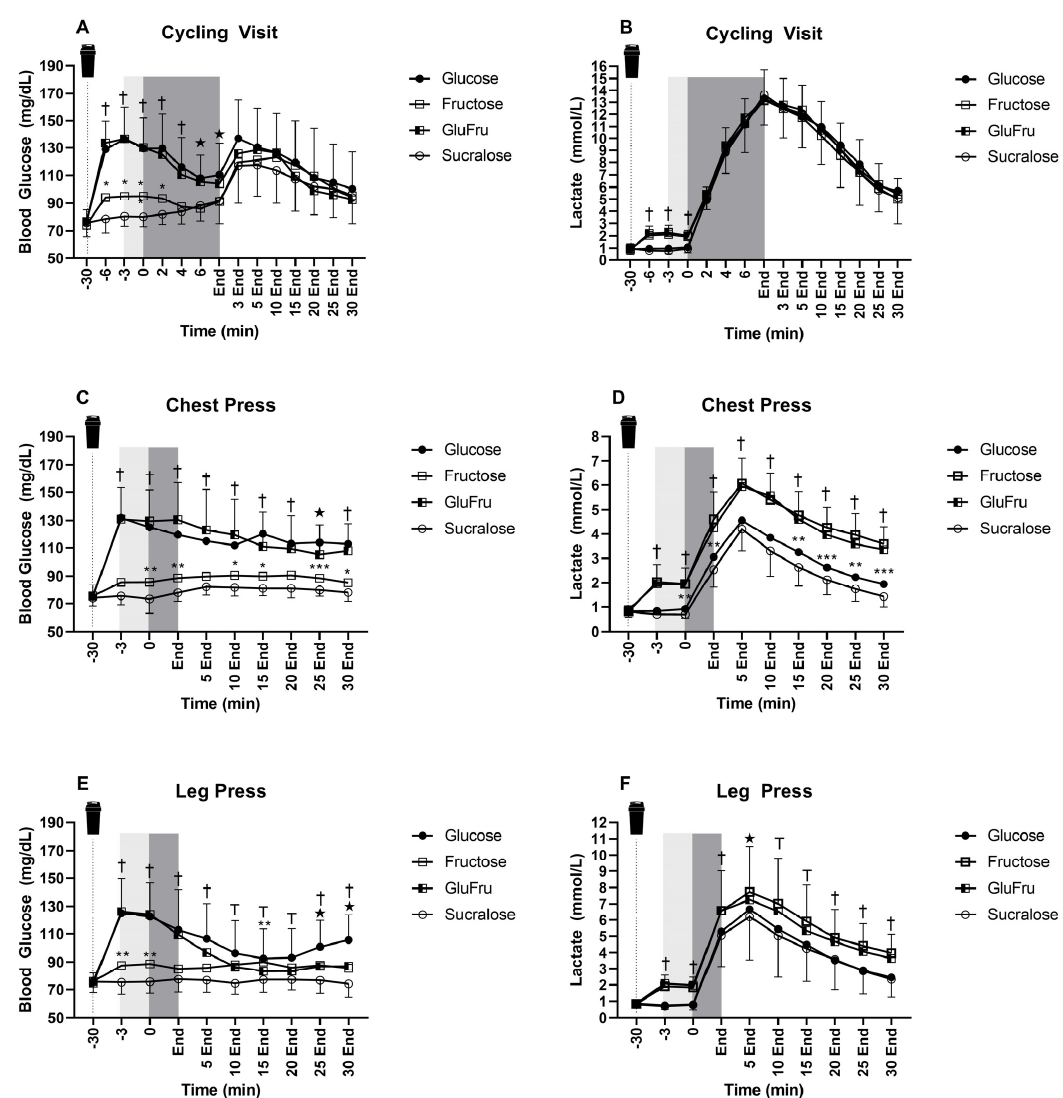
Figure 2. ( A ) Blood lactate during cycling study visits. Black circles indicate Glu. Open Squares indicate fru. Half open squares indicate GluFru. Open circles indicate sucralose. Light grey areas in- dicate warm up periods. Dark grey areas indicate exercise testing. † indicates statistical signi fi cance of Glu and GluFru compared to fructose and sucralose ( p < 0.001). * indicates statistical significance between fructose and sucralose ( p < 0.05), Stars indicate statistical significance of glucose compared to fructose and sucralose ( p < 0.01)., ( B ) Blood lactate during cycling study visits. † indicates statis- tical significance of Fru and GluFru compared to glucose and sucralose ( p < 0.001). ( C ) Blood glucose during chest-press visits. † indicates statistical signi fi cance of Glucose and GluFru compared to Fructose and sucralose ( p < 0.001). * indicates statistical significance between fructose and sucralose ( p < 0.05), ** indicates statistical significance between fructose and sucralose ( p < 0.01), *** indicates statistical significance between fructose and sucralose ( p < 0.001). Stars indicate statistical signifi- cance of glucose compared to Glufru, fructose and sucralose ( p < 0.05). ( D ) Blood lactate during